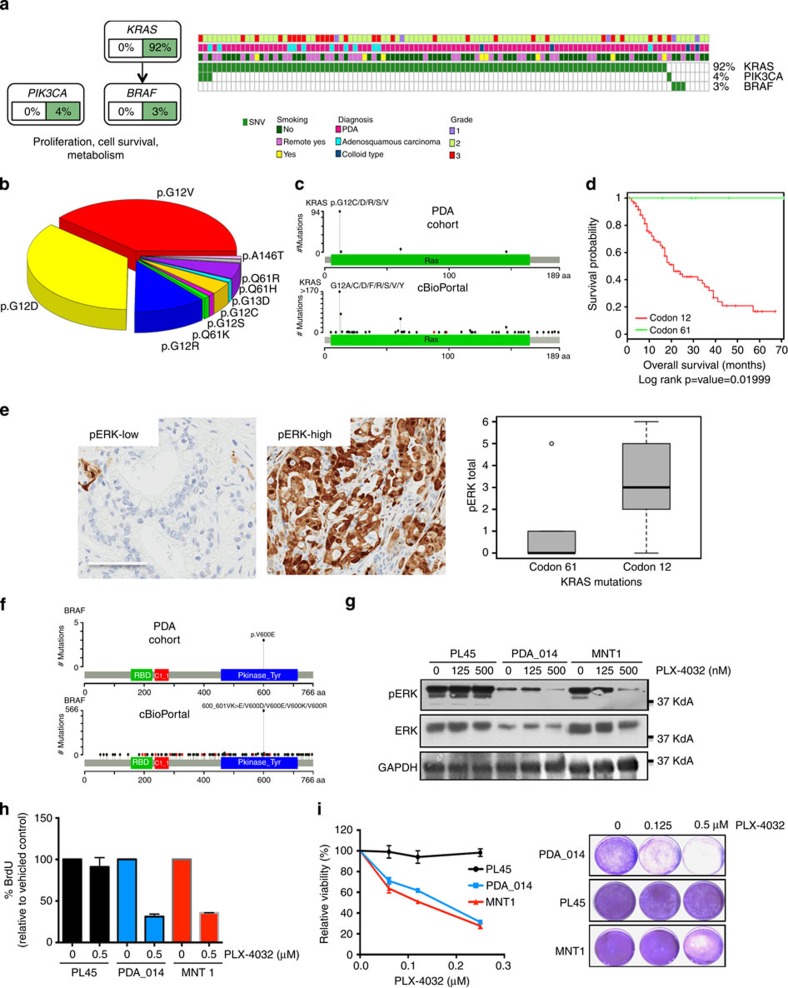
KRAS/BRAF-Pathway in PDA.(a) Oncomap showing the distribution of KRAS, BRAF and PIK3CA mutation in the cohort. (b) KRAS mutations in the cohort exhibit a diverse spectrum concentrated at known oncogenic codons 12, 13 and 61 (c) Analysis of KRAS mutations in the PDA cohort in comparison with all cancer cases in cbioportal (d) Kaplan–Meier analysis of codon 12 versus codon 61 mutated cases. Kaplan–Meier analysis of codon 12 versus codon 61 mutated cases. P value was obtained from Cox proportional hazard test. (e) Representative staining of pERK in pancreatic cancer cases (scale bar, 150 μM), and the association of pERK staining in PDA cases with KRAS codon 12 versus codon 61 mutations. The boxes show the distance between the first and third quartile with the whiskers extending up to 1.5 times the interquartile range. (f) Analysis of BRAF mutations identified in the PDA cohort in comparison with the analysis of all cancer cases in bioportal. (g) Impact of PLX-4032 on the phosphorylation of ERK in the indicated cell lines. PL45 is KRAS mutated, PDA_014 is a patient-derived cell line harbouring BRAF V600E and MNT1 is a BRAF V600E melanoma cell line (h) Impact of PLX-4032 on cell cycle progression in the indicated cell lines (data analysis was performed in triplicate and error bars denote s.d.). (i) Impact of PLX-4032 on viability in the indicated cell lines (data points are from at least six values and error bars denote s.d.).